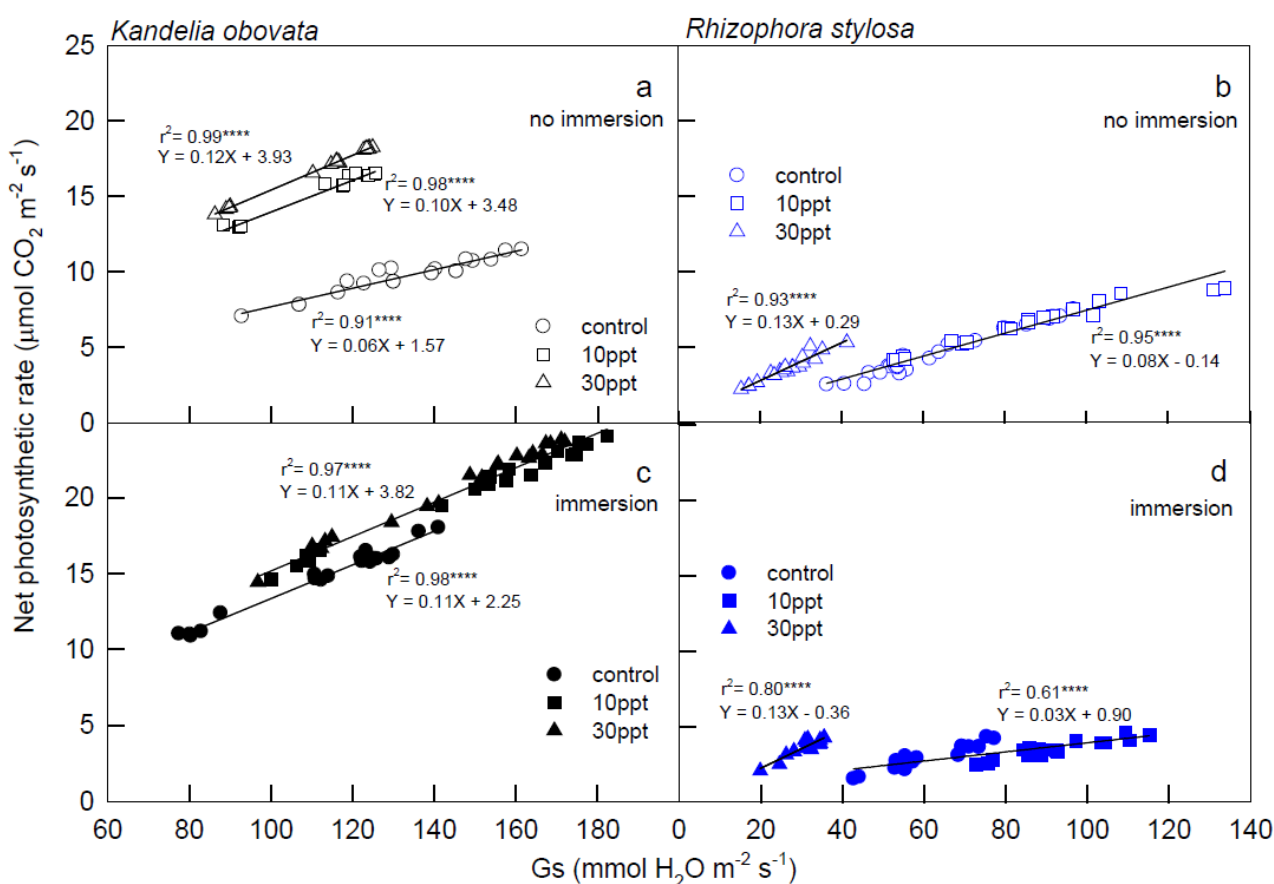
Figure 3. The relationship between stomatal conductance (Gs) and net photosynthetic rate (Pn) of K. obovata ( a , c ) and R. stylosa ( b , d ) cultivated under 0, 10, and 30 ppt salinity treatments with ( c , d ) and without ( a , b ) immersion conditions. Measurements were recorded at 25 °C and 1200 − 2000 μ mol·m −2 ·s −1 PPFD. Each symbol represents the average of one leaf on one seedling, and five seedlings were randomly selected from each treatment under 1200, 1500, 1800, 2000 PPFD luminosity changes, and a total of 20 values were used for each linear regression analysis. Determination coefficient (r 2 ) provides a measure of regression model fit, and the model p -values indicate model significance at p < 0.0001, denoted with ****.